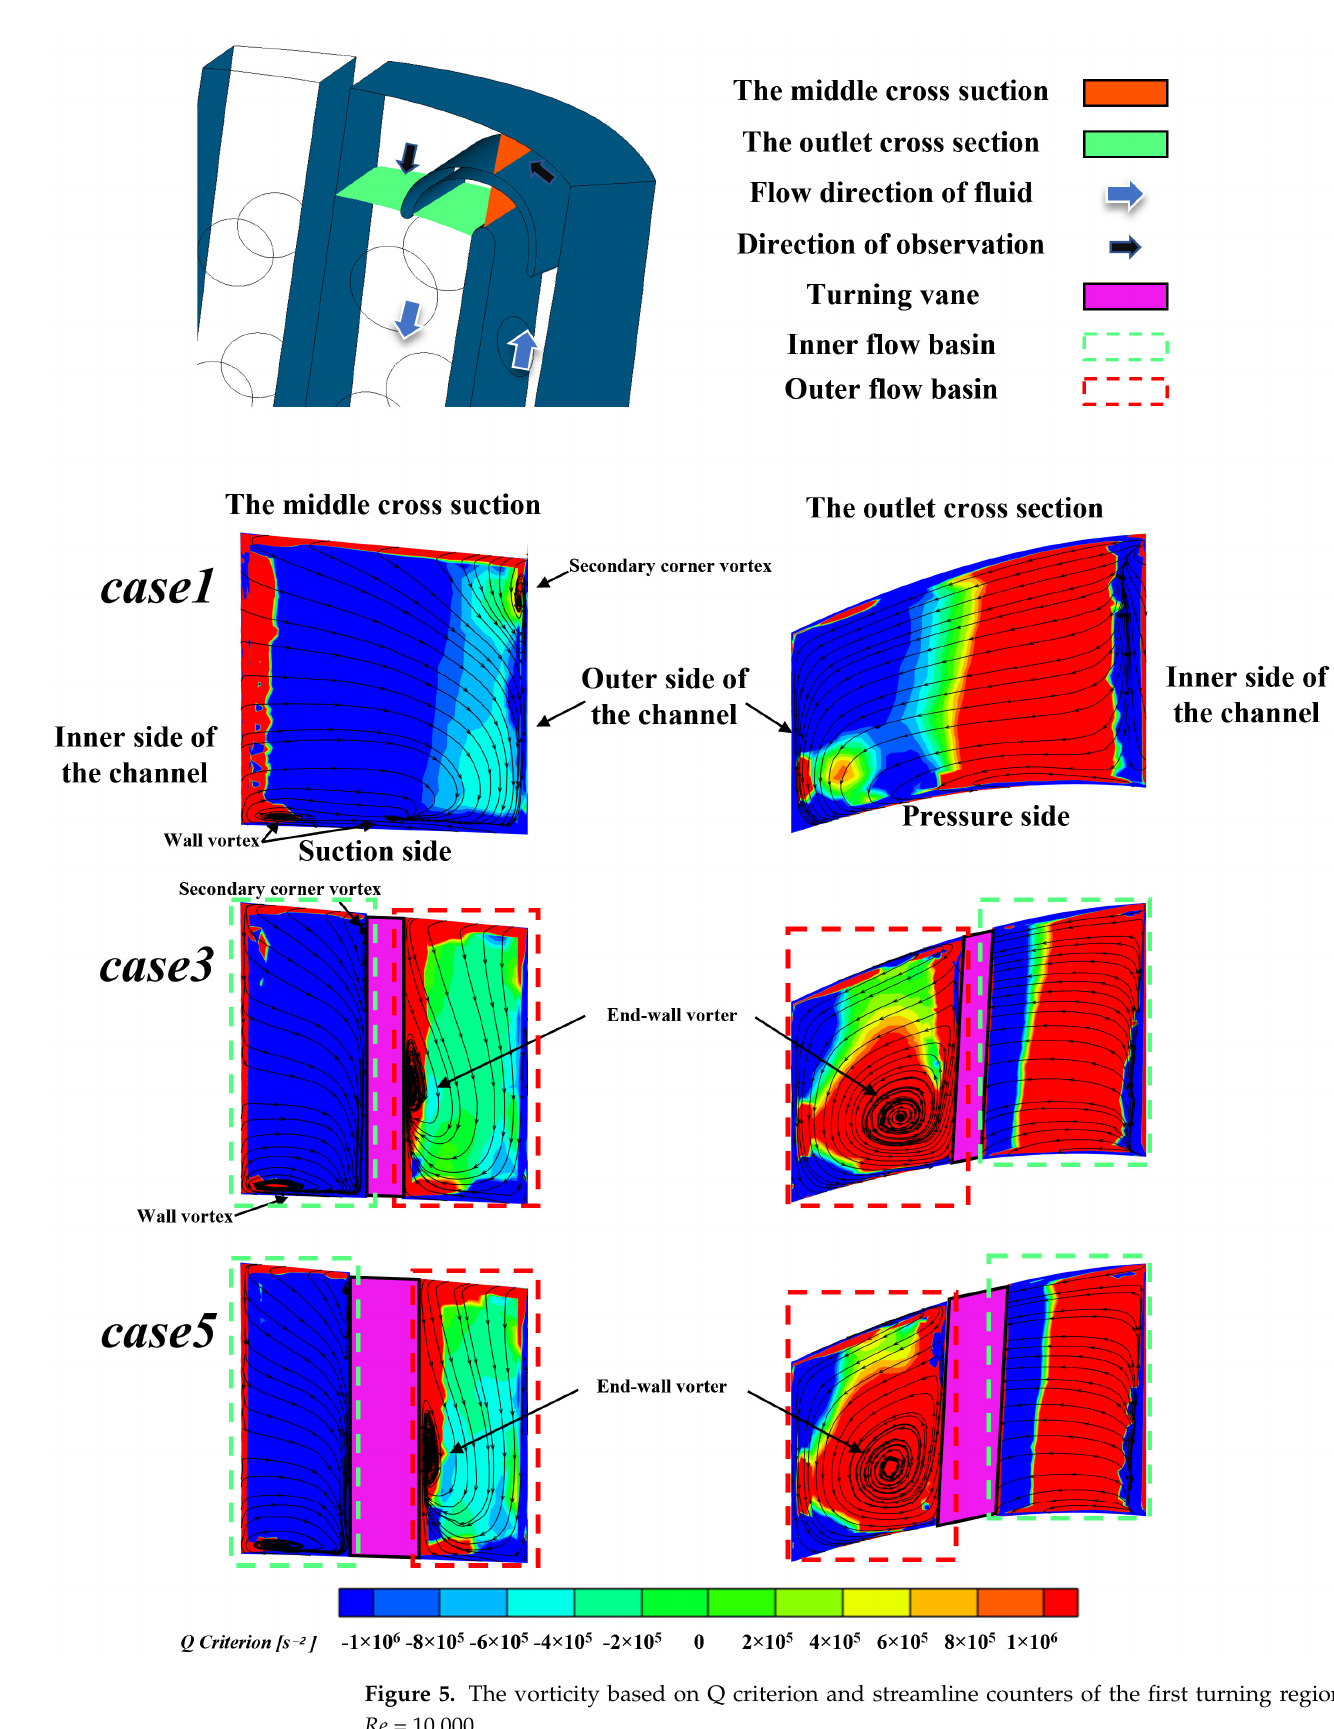
Figure 5. The vorticity based on Q criterion and streamline counters of the first turning region, Re = 10,000.